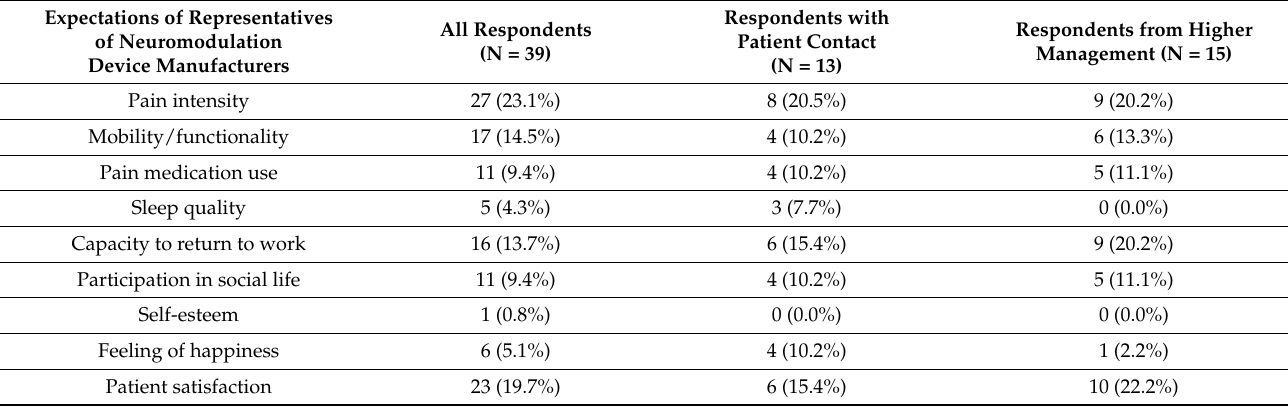
Figure 1. Plot representing the top three factors that representatives of neuromodulation device manufacturers believe will change due to neuromodulation for pain. On the y-axis, the absolute frequency, i.e., the total number of responses, is presented. Table 2. Survey respondents reported a total of 117 factors that are expected to change with neuromodulation for pain. The absolute frequency and percentage of the top three factors that were selected by representatives of neuromodulation device manufacturers are presented. Percentages are calculated according to the number of factors selected for each group, meaning 117 factors for all respondents, 39 factors for respondent with patient contact, and 45 factors for respondents belonging to higher management.